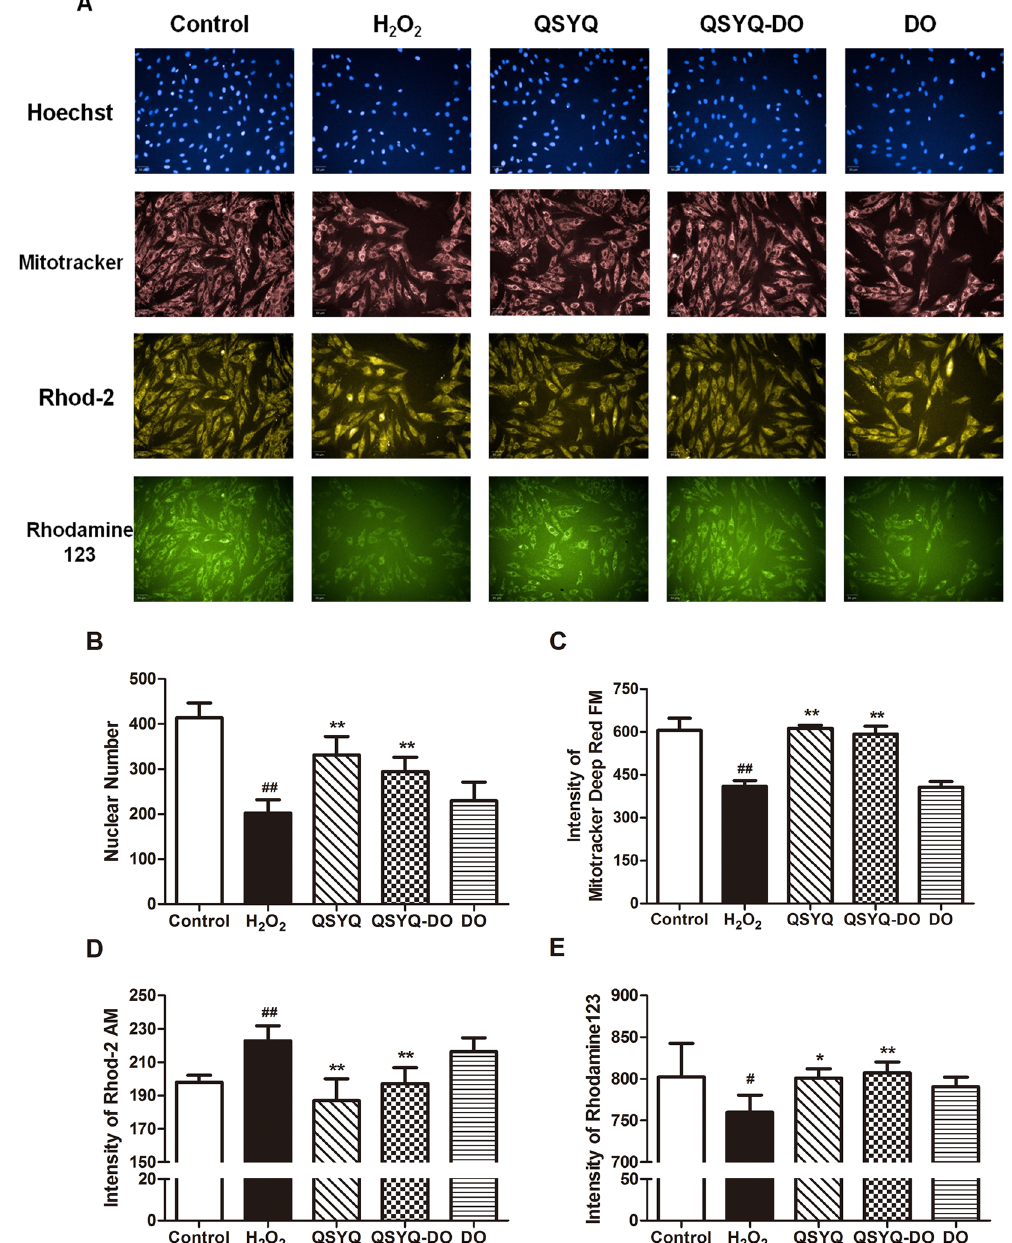
Figure 2. Effects of QSYQ and QSYQ-DO on mitochondrial structure and function against H 2 O 2 injury. H9c2 cardiomyocytes were treated with QSYQ, QSYQ-DO or DO volatile oils at a concentration of 0.2 mg/mL for 24 h and then exposed to 200 μ M H 2 O 2 for 2 h. ( A ) Representative images of mitochondrial structure and function were captured in Operetta High Content Imaging System. Fluorecent stains: Hoechst for nuclei and cell numbers (blue); Mitotracker for mitochondrial mass (red); Rhod-2 AM for cytosolic Ca 2 + (yellow) and Rhodamine 123 for ΔΨ m (green). (B–E) Quantitative analyses of fluorescence intensities in ( A ). Data are expressed as the mean ± SD, n = 3. # p < 0.05, ## p < 0.01 vs . Control group. * p < 0.05, ** p < 0.01 vs . H 2 O 2